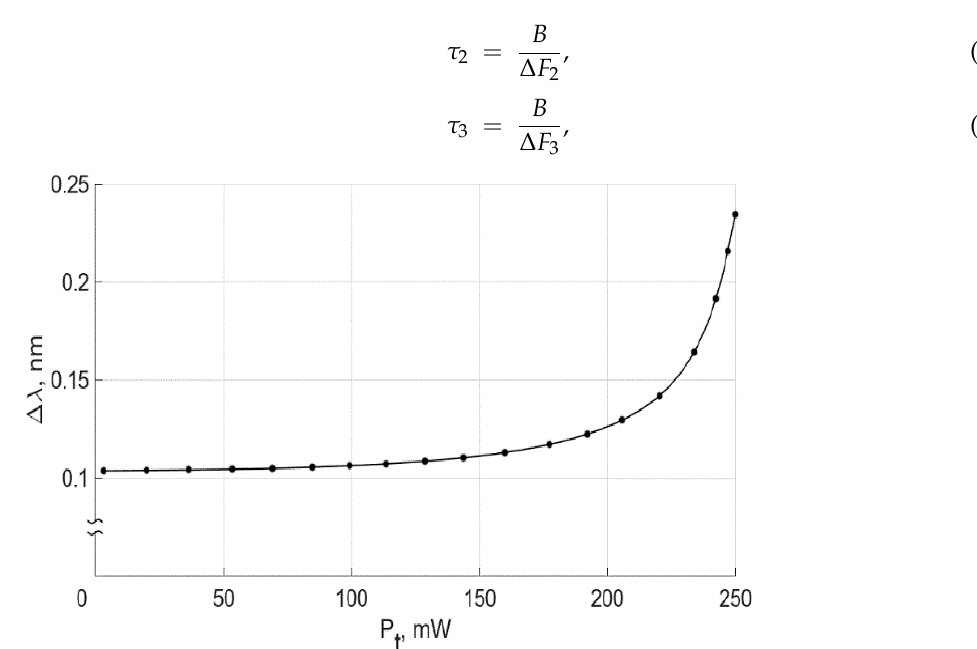
Figure 4. Dependence of the change in the linewidth Δ λ of laser radiation on the power P t at a temperature T = 293.2 K.